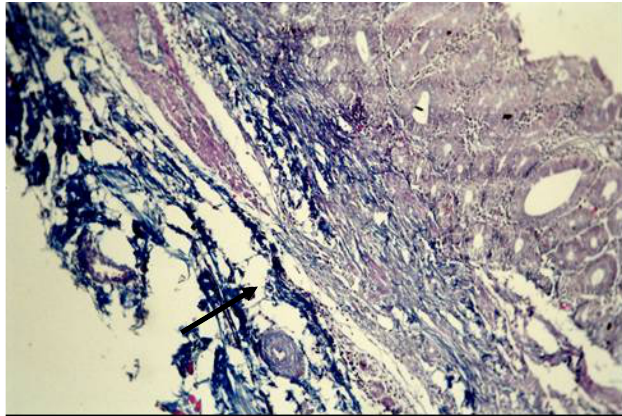
FIGURE 6 – Inflammatory reaction substitution by fibrosis, in blue, at the muscular layer interruption spot (arrow). Massom trichromic coloration. 10 X